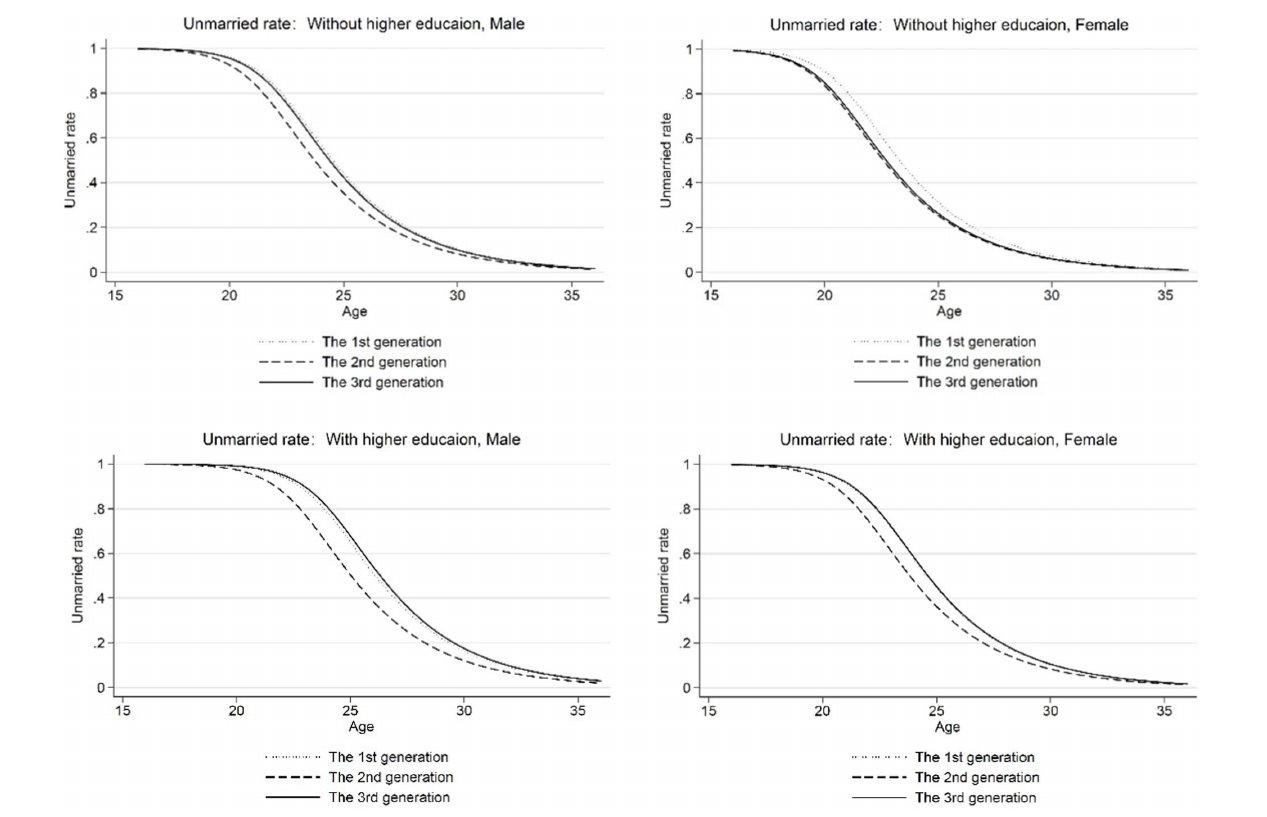
FIGURE 3 Age—unmarried rate (controlling for micro variables). Micro variables include the parent’s level of education, the number of siblings, and the maximum age difference between the parents and their